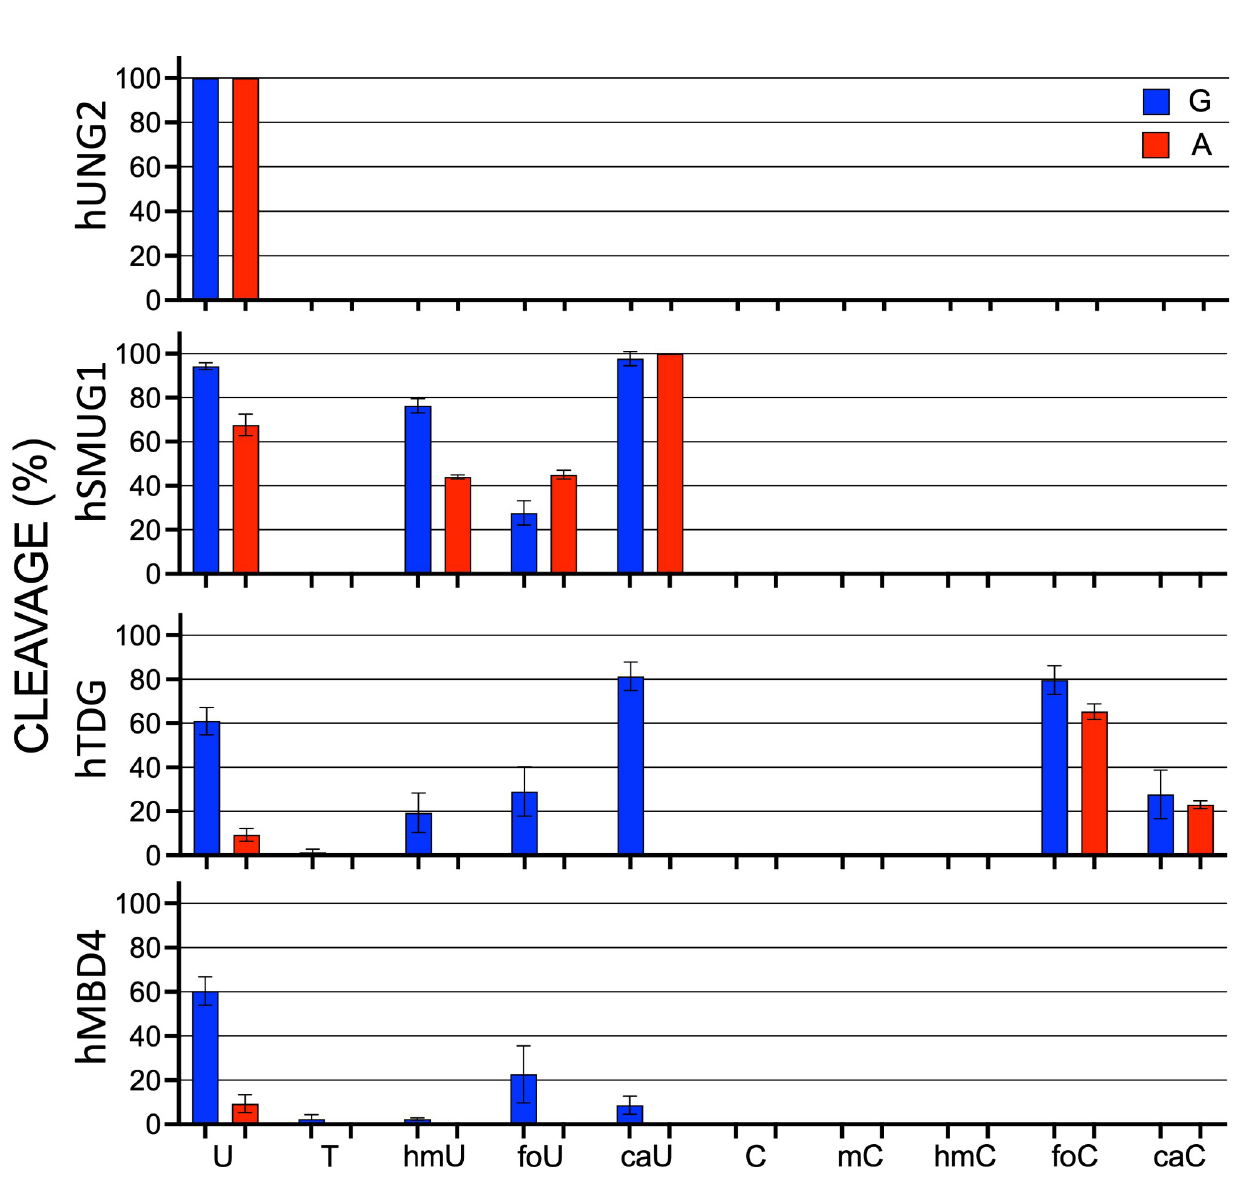
Fig 7. Summary for human glycosylase specificity for substrate. U, T, 5hmU, 5foU, 5caU, C, 5mC, 5hmC, 5foC and 5caC (mispaired with G (blue) or A (red)) oligonucleotides were treated with indicated enzymes for 1 hour at 37˚C, and subsequently treated with hyTDG-lyase (Y163K) or NaOH to break the DNA backbone at the abasic site, mixed with an equal volume of formamide, and separated in 20% polyacrylamide denaturing gel. Gels were visualized using a STORM gel imager. Data presented as average value ± SD (n = 3).